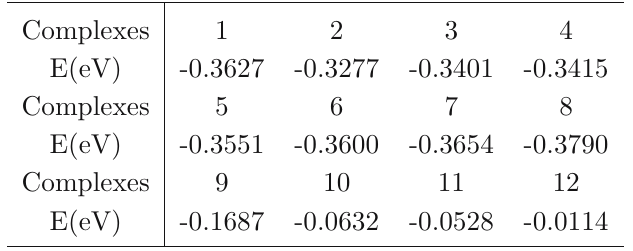
Table 1 Binding energy ΔE of complexes 1 through